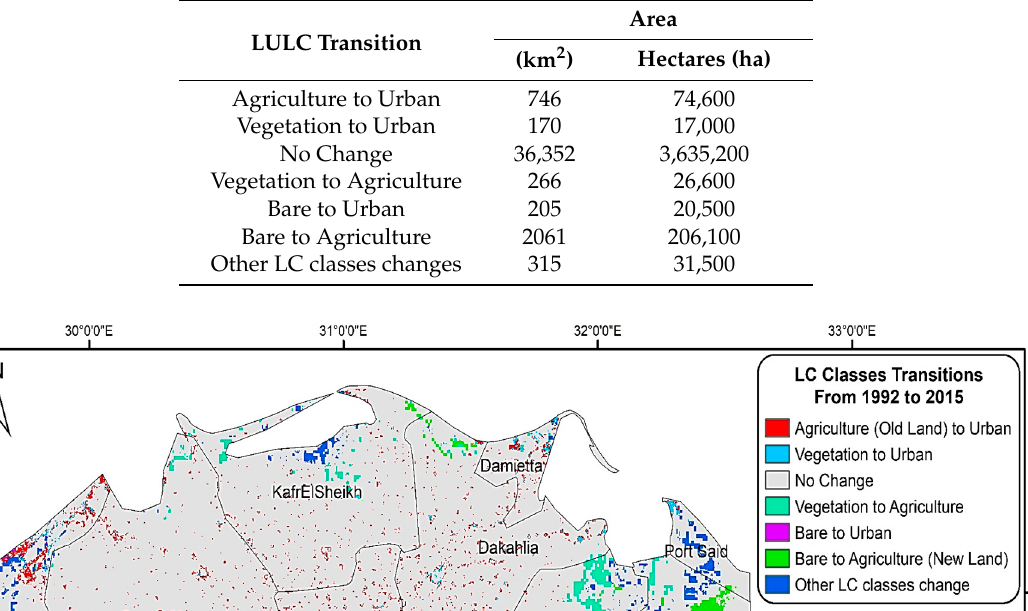
Table 2. Areas of transitions changes within LULC classes in the Nile Delta from 1992 to 2015.